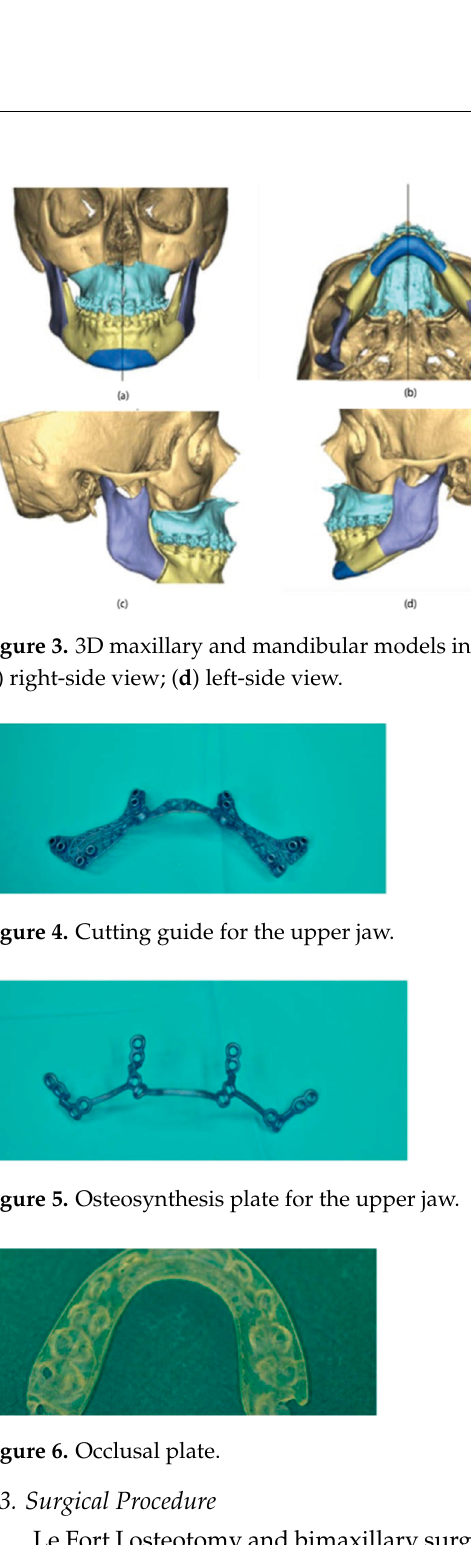
Figure 6. Occlusal plate.